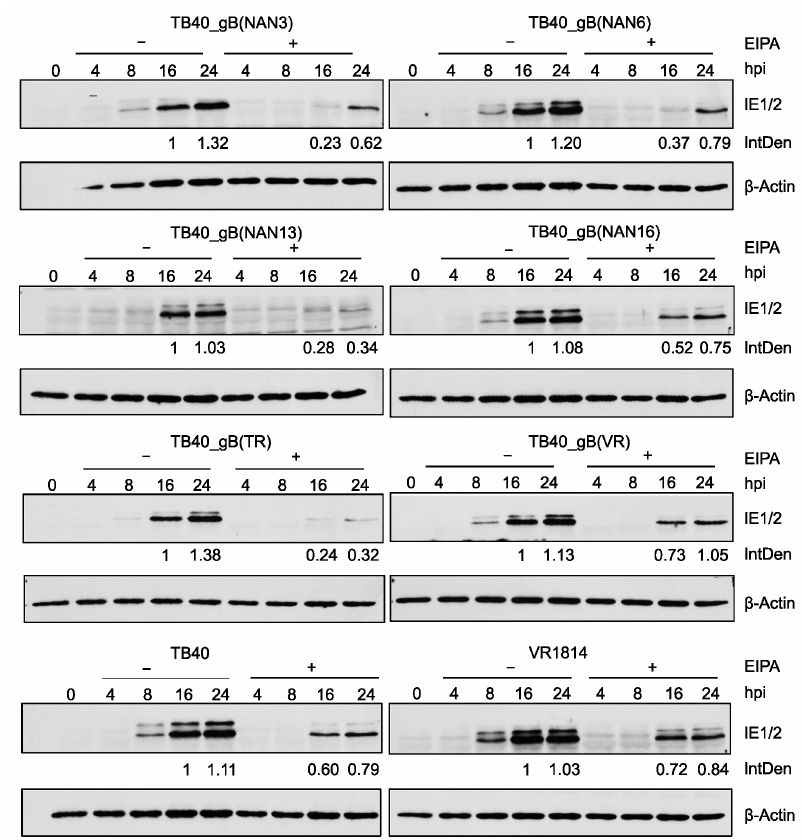
Figure 7. Inhibition of virus entry and IE gene expression by the macropinocytosis inhibitor EIPA. MRC-5 cells were pretreated for 30 min with 50 μ M of EIPA and infected in the presence of EIPA at an MOI of 0.5. Two hours post-infection (hpi), EIPA was removed and fresh medium was added. Cells were harvested at the indicated times and IE1/IE2 expression was analyzed by immunoblot. IE1 expression levels at 16 and 24 hpi were measured by densitometry and normalized to β -actin levels. Numbers indicate IE protein levels relative to the levels at 16 hpi in untreated ( − EIPA) cells. IntDen, integrated density.